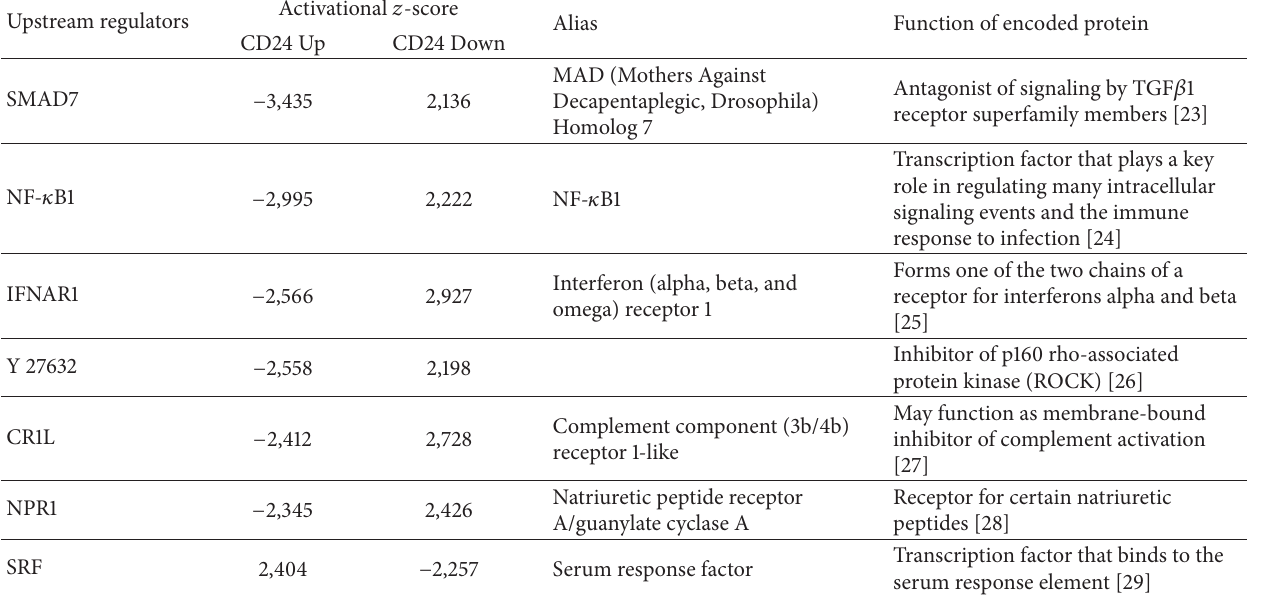
Table 1: IPA upstream regulator analysis. Molecules resulting in similar changes in the pattern of gene expression as the overexpression of CD24 or the knockdown of CD24 are designated with high activational 𝑧 -score values. Listed are those molecules with a 𝑧 -score higher than 2 while exhibiting opposing algebraic signs in the CD24 Up and CD24 Down